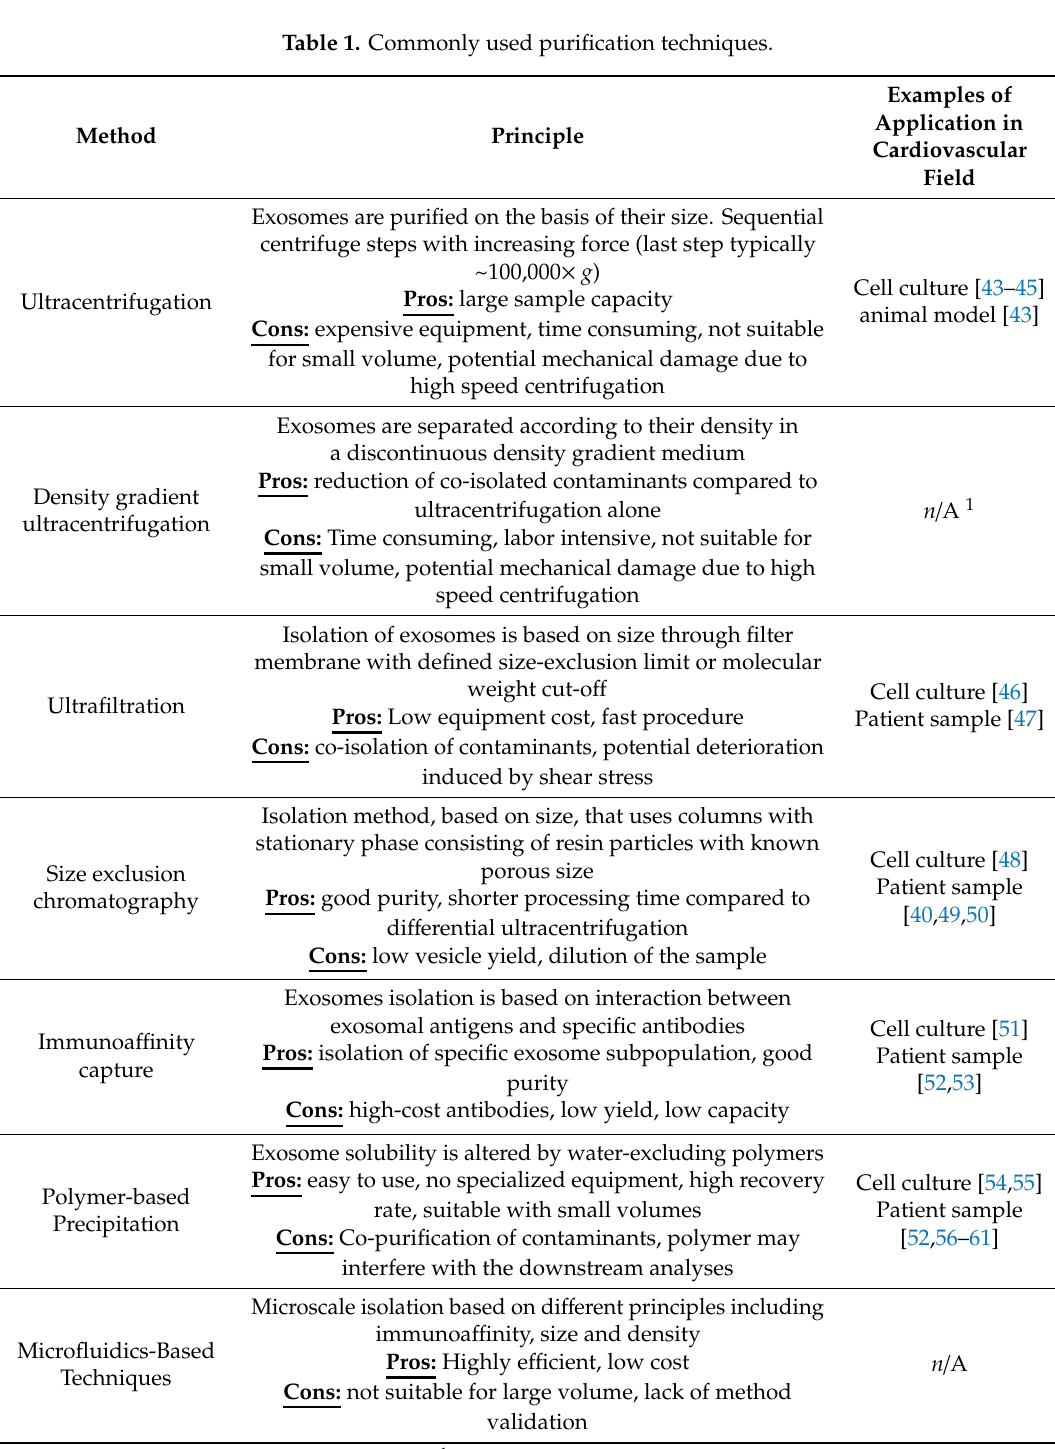
Table 1. Commonly used purification